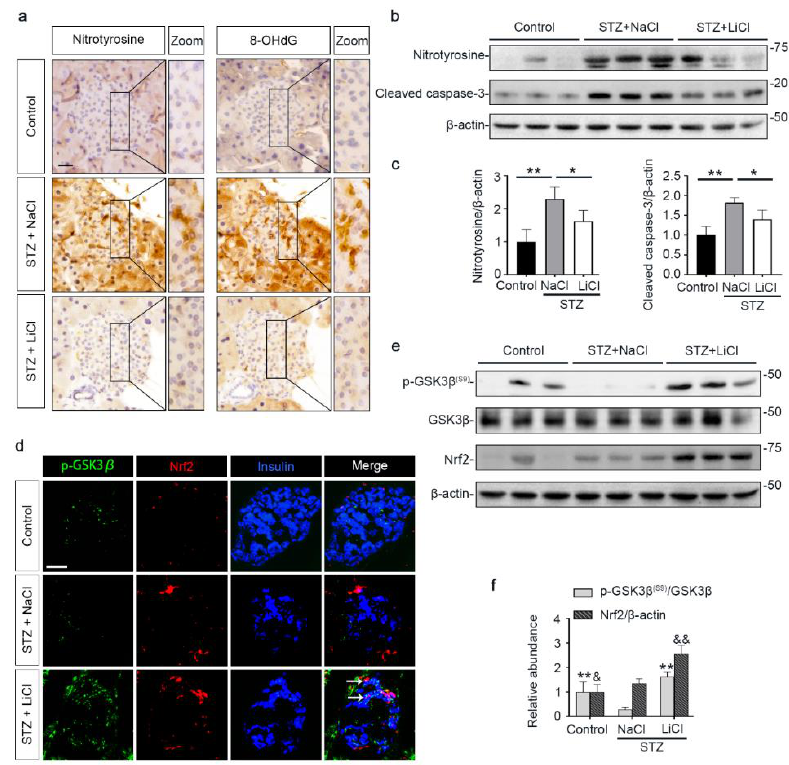
Figure 3. STZ-elicited oxidative stress in pancreatic islets is mitigated by microdose lithium therapy, concomitant with GSK3β inhibition and increased Nrf2 expression. Animals were treated as elaborated in Figure 1. ( a ) Formalin-fixed, paraffin-embedded pancreas specimens were sectioned and subjected to peroxidase immunohistochemistry staining for nitrotyrosine and 8-OHdG, and representative micrographs are shown. Scale bar = 20 µm. ( b ) Isolated islets were prepared for immunoblot analysis for nitrotyrosine, cleaved caspase-3 and β-actin, followed by ( c ) the densitometric analyses, in which the relative abundance of nitrotyrosine and cleaved caspase-3 were normalized with β-actin. Data were expressed as fold changes over control and presented as mean ± SD; * p < 0.05, ** p < 0.01 ( n = 5). ( d ) Cryosections of pancreatic tissues were processed for fluorescent